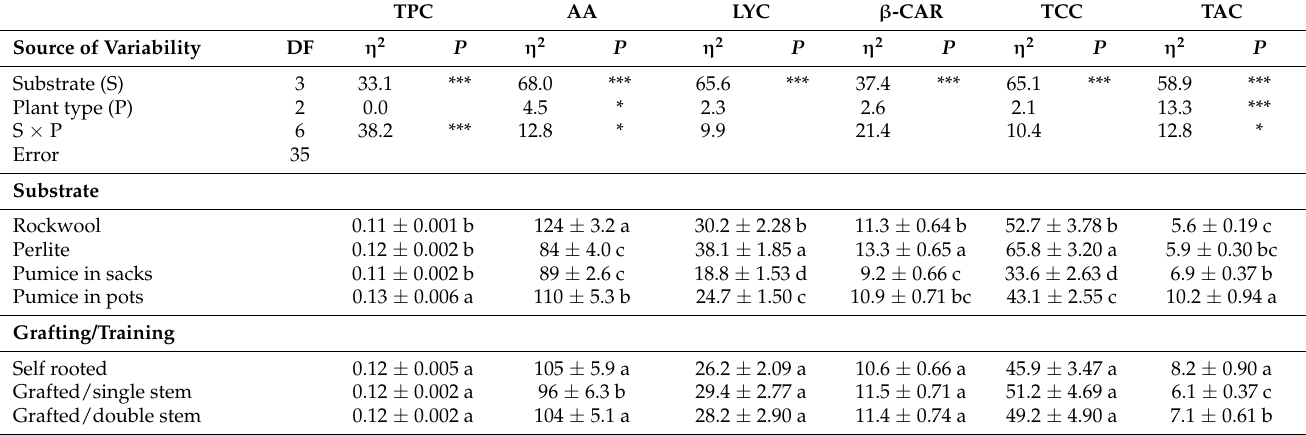
Table 12. Analysis of variance for average functional quality traits (total phenolic content: TPC, ascorbic acid: AA, lycopene: LYC, beta carotene: β -CAR, total carotenoid content: TCC, total antioxidant capacity: TAC) of tomato fruit harvested on 6 November. The fruit was obtained from self-rooted ‘Beef Bang F1’, ‘Beef Bang F1’ grafted onto ‘Defensor’, trained in